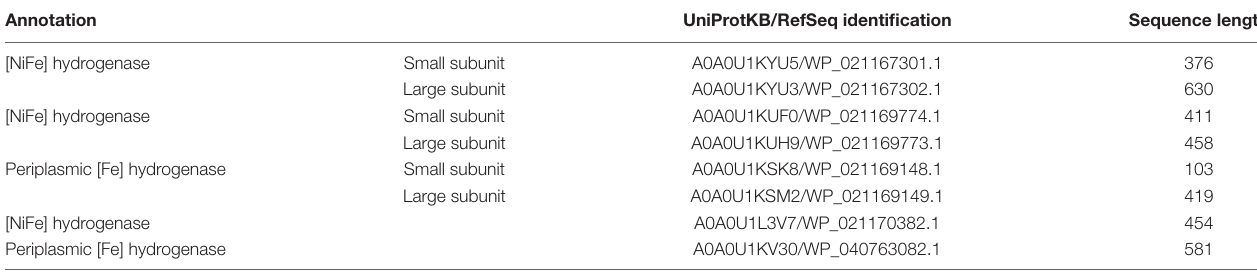
TABLE 1 | Annotated hydrogenases of S. ovata 2662.